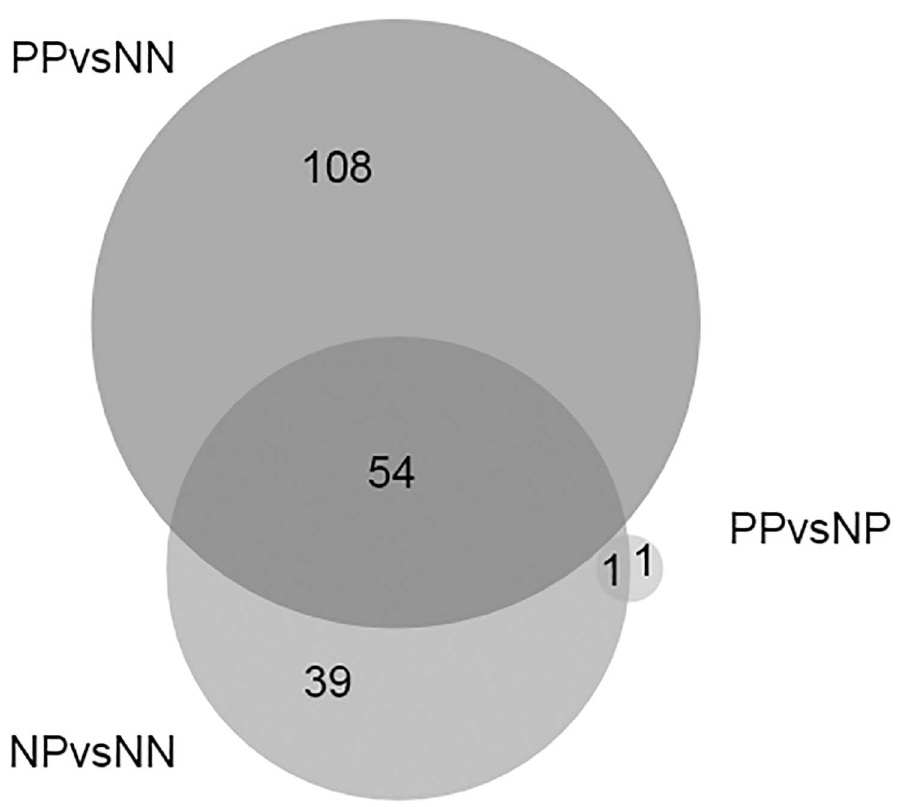
Fig 1. Venn diagram showing the number of common and specific differentially expressedgenes for each